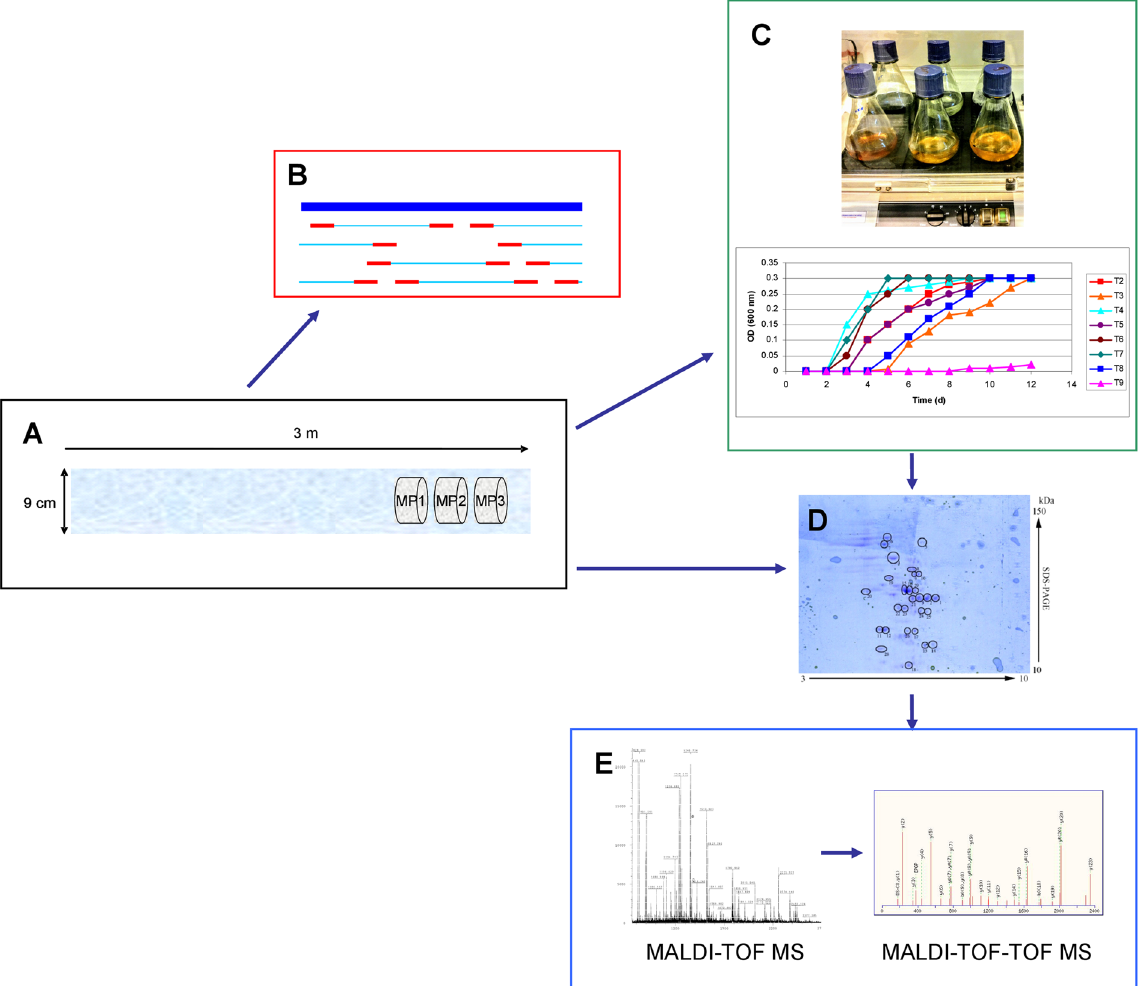
Figure 3. Summary of the overall experimental strategy. ( A ) Sampling (3 direct ice samples: MP1, MP2 and MP3). ( B ) 16S rRNA gene sequencing. ( C ) Cell cultures and growth rates were monitored by optical density at 600 nm. ( D ) Coomassie stained 2-DE gels. ( E ) MALDI-TOF and MS/MS fragment ion